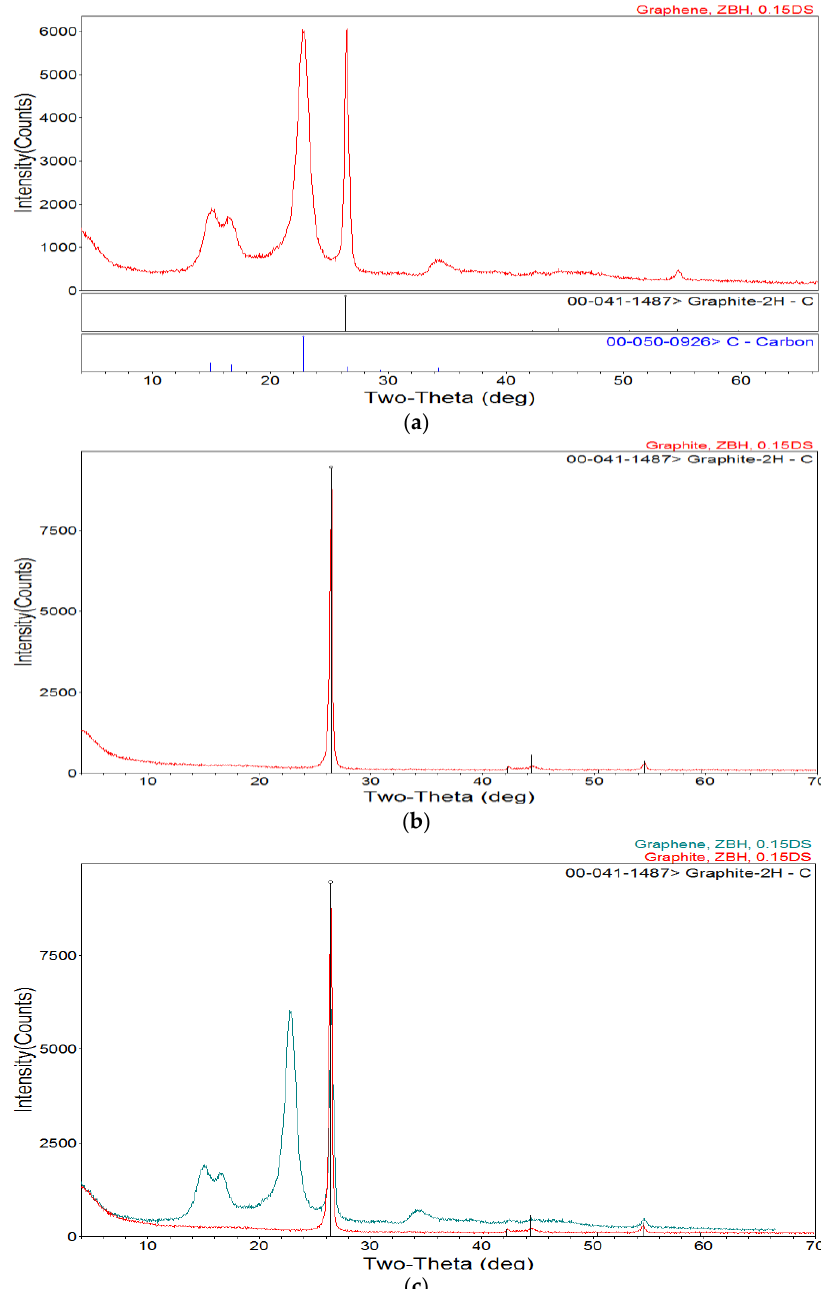
Figure 5. X-ray diffraction patterns of ( a ) graphene and ( b ) graphite; and ( c ) overlay of graphite and graphene. ‘ZBH’ describes the background holder, ‘DS’ describes the slit resolution and 00-14-1487 is a reference code to compare graphite with a standard value.